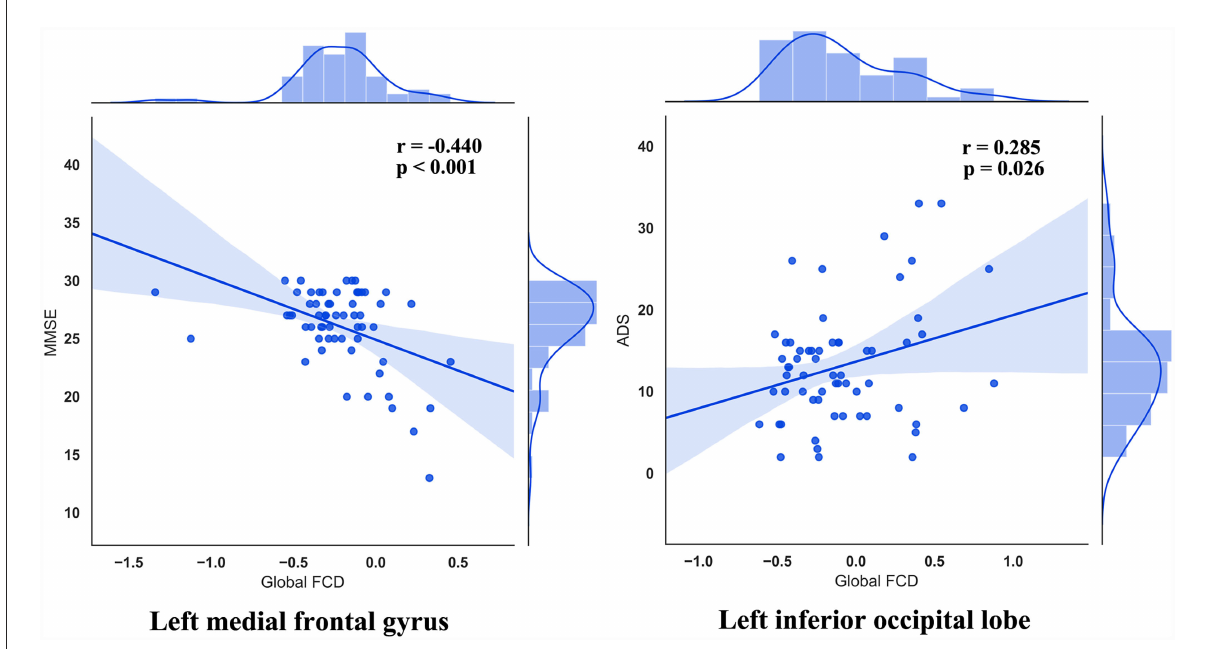
FIGURE3 The association between altered FCD with clinical symptoms.